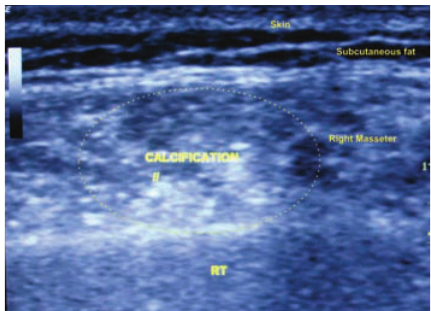
Figure2:Greyscaleultrasoundimagerevealingamixedecholesion with a phlebolith in the right